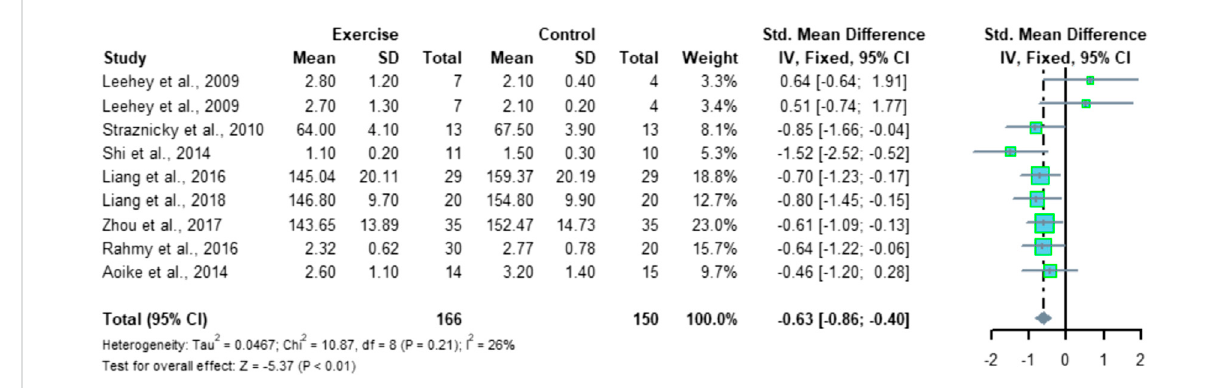
Meta-analysis of aerobic exercise affecting SCr.